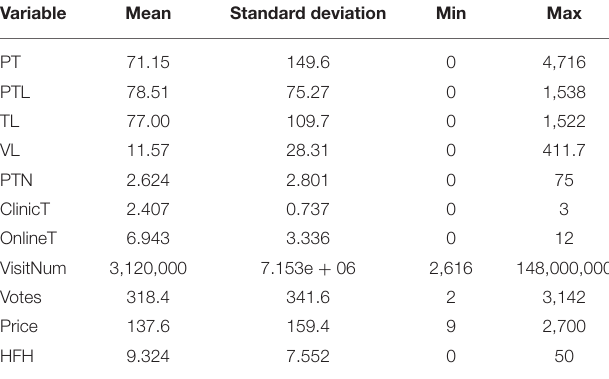
TABLE 3 | Descriptive statistics for the variables ( N = 1,537).